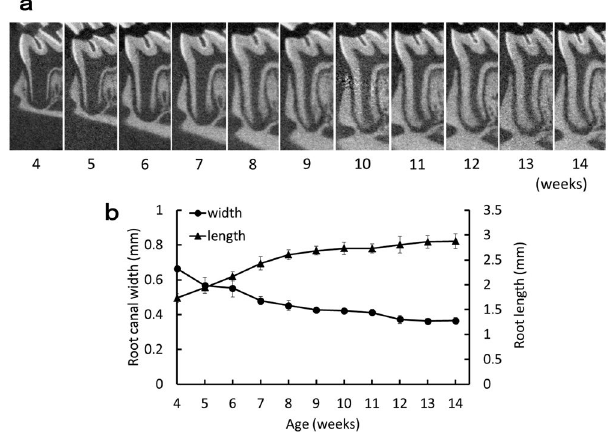
Figure 3. Age-related change in the mesial root of the mandibular first molar. ( a ) Representative micro-CT images of the mesial root of the mandibular first molar at each week of age. ( b ) Age-related change in root length and root canal width. Root length was measured from the pulpal floor to the root apex; the root canal width was measured at 1 mm apically from the pulpal floor. Data represent the means of four sample measurements; error bars indicate standard